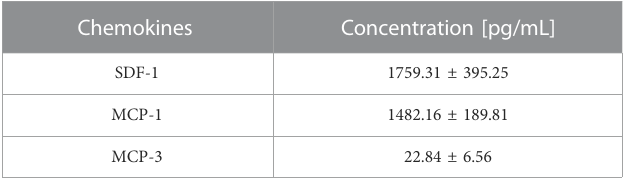
TABLE 2 Chemokine analysis in secretome of SUI myo fi broblasts by multiplex assay ( n = 6). Chemokines